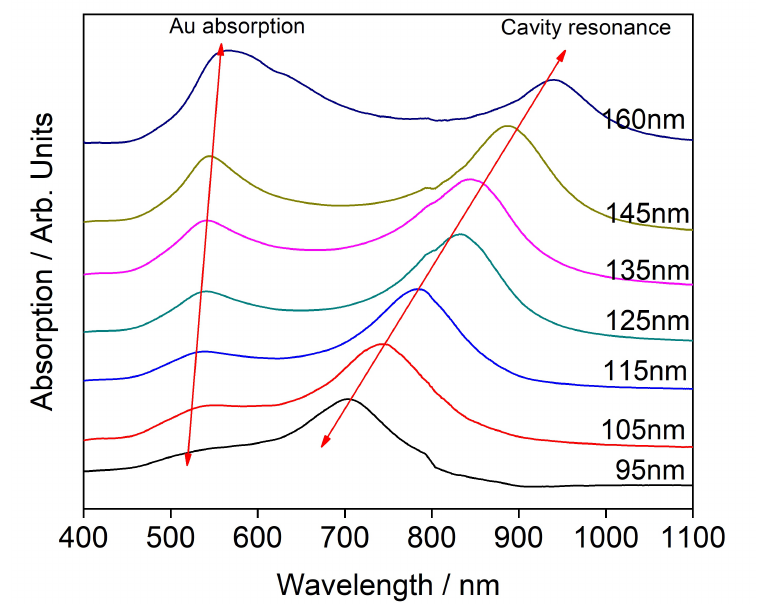
Figure 2. Absorption spectrum of C 60 in gold cavity.